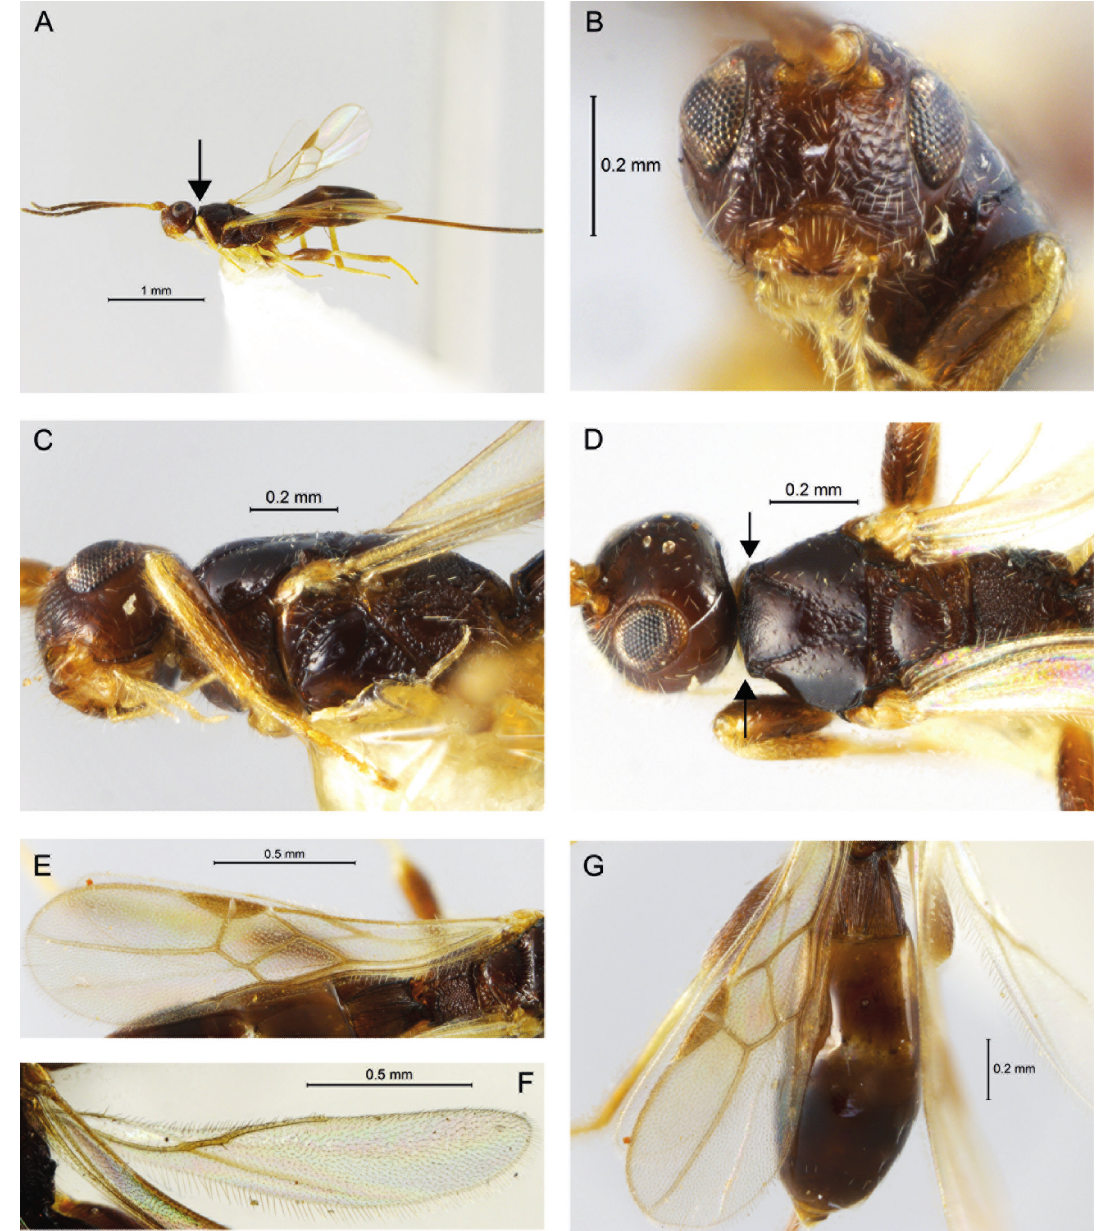
Fig. 1. Hecabolus acutus sp. nov., ♀, holotype (NHMUK). A . Habitus, lateral view. B . Head, frontal view. C . Mesosoma, lateral view. D . Mesosoma, dorsal view, black arrows indicate the middle mesoscutal pointed edges above notaulli. E . Fore wing. F . Hind wing. G . Metasoma, dorsal